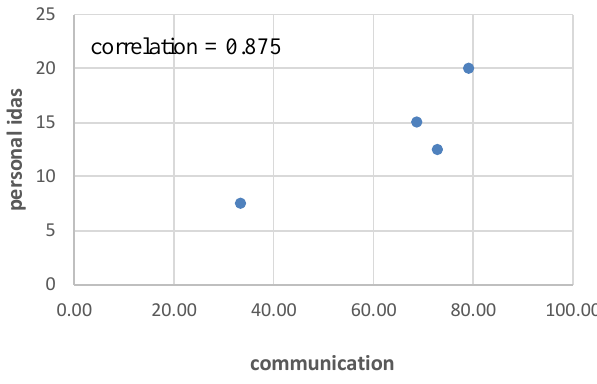
Fig. 3. Using the agreement on questions regarding communication as a measure of the effort to communicate, it is plotted against the number of individual ideas averaged per team. Each dot presents one Fig. 1. Note that the replies from teammates may differ from one another and the individual ideas do not always add up to the given collective ideas. For both individual and collective, a majority stated they would produce the same number of ideas in a MD setting.